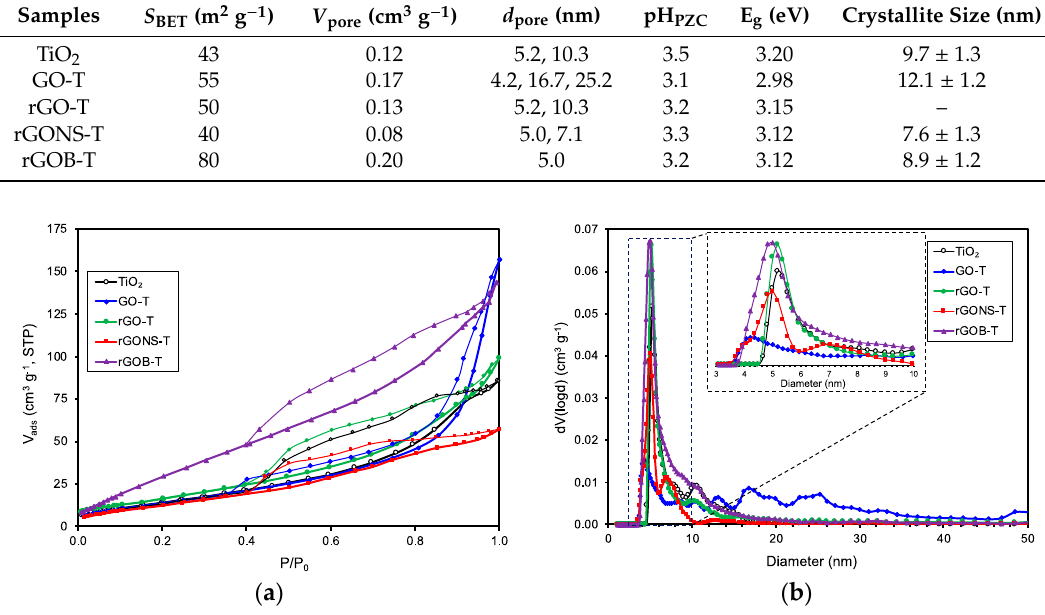
Figure 2. ( a ) N 2 adsorption-desorption isotherms and ( b ) pore size distributions obtained by the quenched solid density functional theory (QSDFT) method of TiO 2 , GO-T, rGO-T, rGONS-T, and rGOB-T. Table 1. Brunauer–Emmett–Teller (BET) surface area ( S BET ), total pore volume ( V pore ), mean pore diameter ( d pore ), pH at the point of zero charge (pH PZC ), band-gap energy (E g ), and crystallite size of synthetized materials.